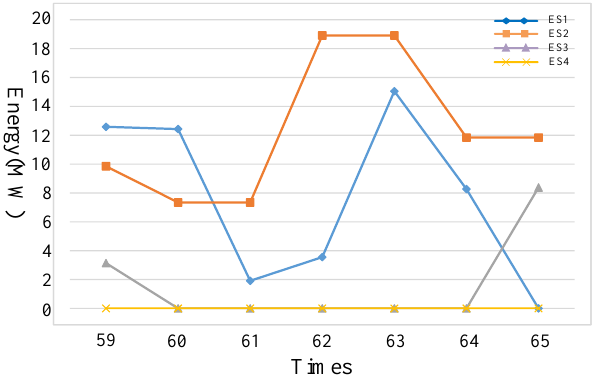
Figure 19. The results in six groups of ESSs.